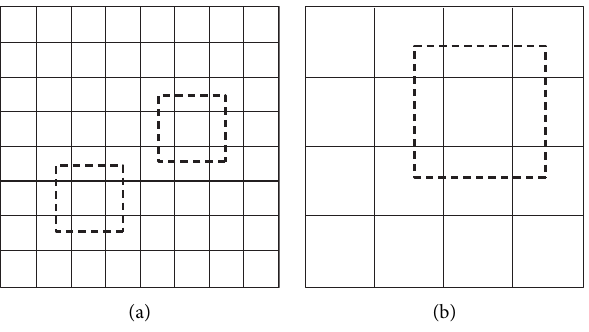
Figure 5: Feature maps at different scales [25]: (a) 8 × 8 feature map and (b) 4 × 4 feature map. VGG-16 through Conv5–3 layer